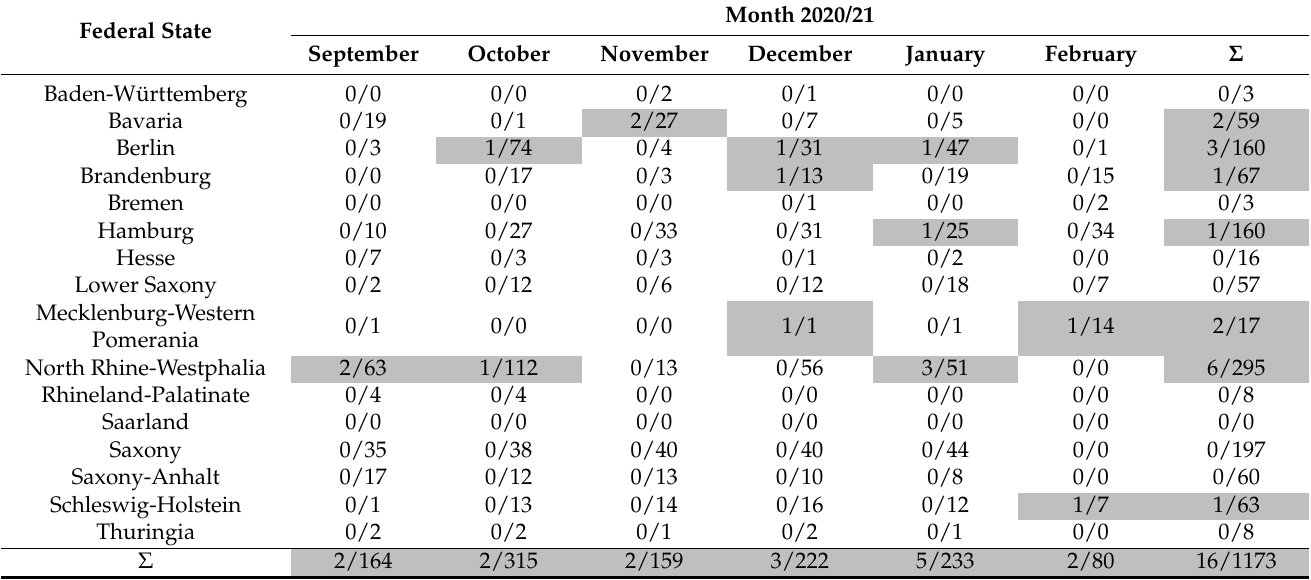
Table 1. Results of the indirect ELISA against the receptor-binding domain (RBD) of severe acute respiratory syndrome coronavirus 2 (SARS-CoV-2). The number of positive cat sera is given in the context of all tested samples for a specific month in each German federal state.